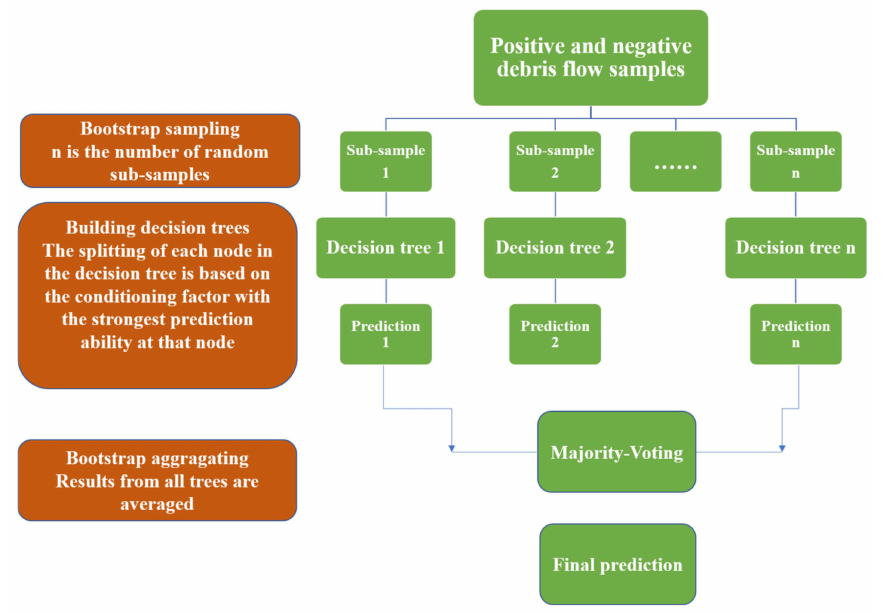
Figure 4. The schematic diagram of